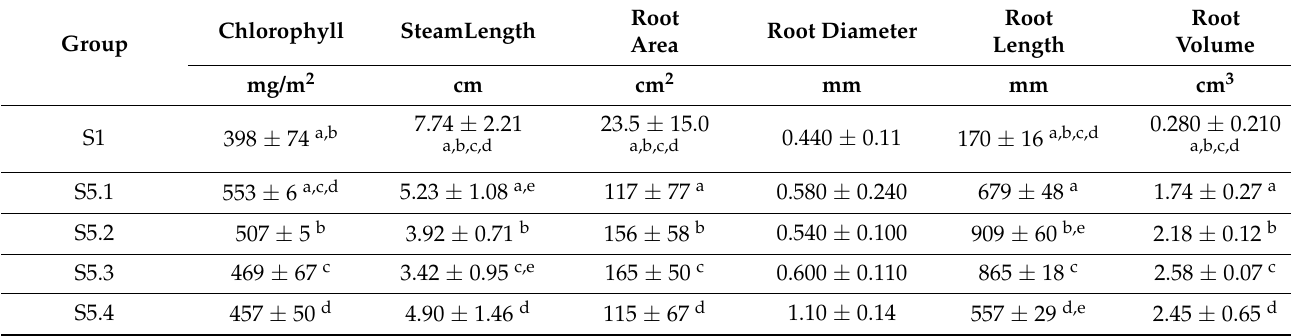
Table 9. Effect of coating thickness with micronutrients and AAt on growth parameters of cucumber—pot tests) (S1— Uncoated seeds, S5.1—Seed coating containing a solution of 2% alginate with amino acids (37.6 mL/100 g), micronutrients (37.5 mL/100 g), and NPK, S5.2—Seed coating containing a solution of 2% alginate with amino acids (75.1 mL/100 g), micronutrients (75.1 mL/100 g), and NPK, S5.3—Seed coating containing a solution of 2% alginate with amino acids (112 mL/100 g), micronutrients (112 mL/100 g), and NPK, S5.4—Seed coating containing a solution of 2% alginate with amino acids (150 mL/100 g), micronutrients (150 mL/100 g), and NPK).